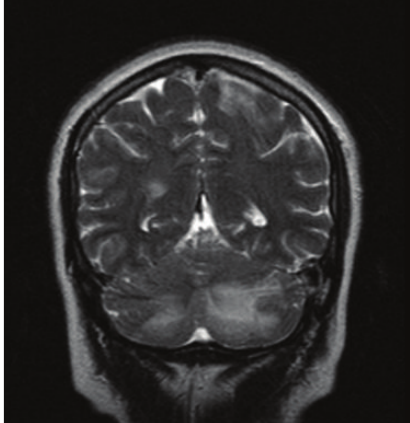
Figure 3: MRI, T 2 -weighted coronal image: hyperintense signal on bilateral occipital and cerebellar